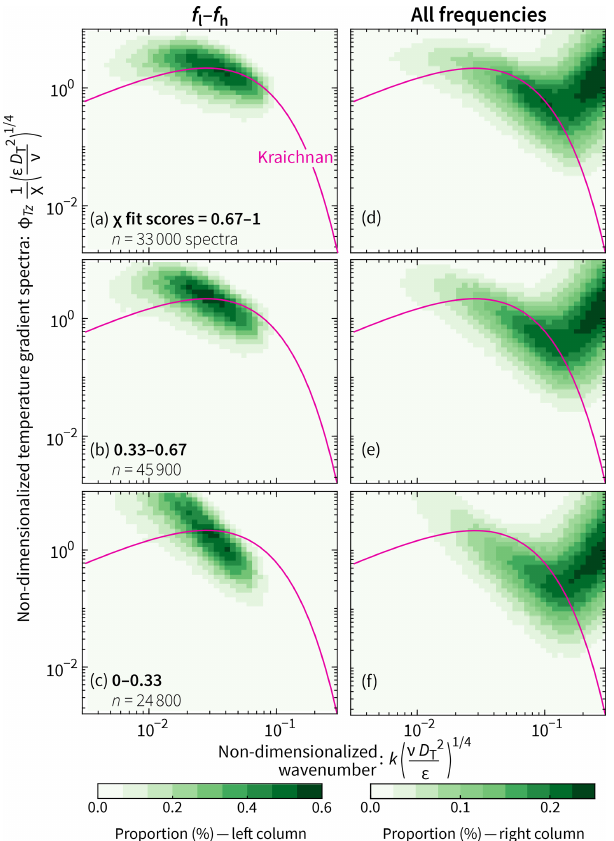
Figure 10. Same as for Fig. 7 but for temperature gradient rather than